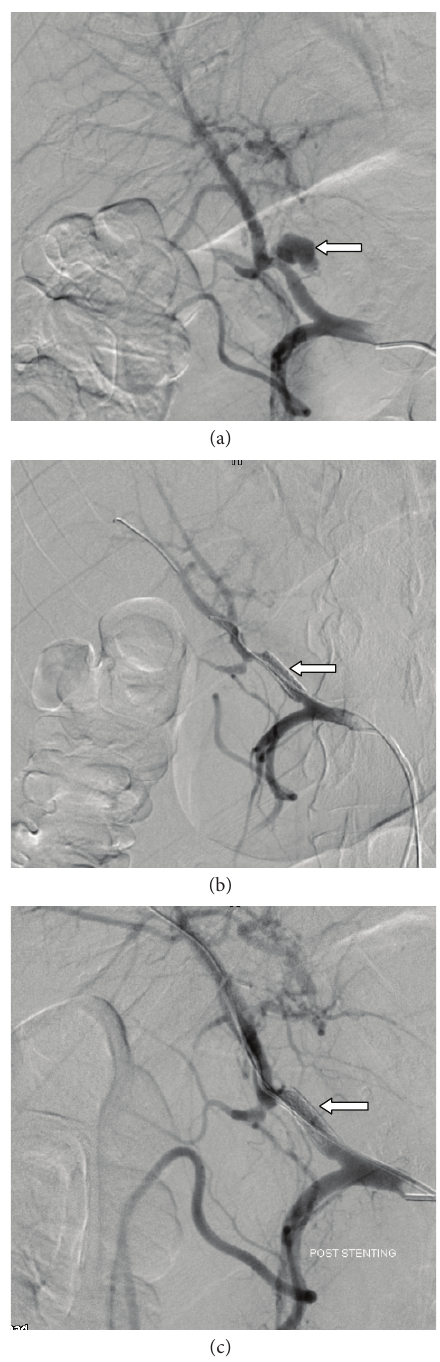
Figure 3: (a) Pseudoaneurysm arising from left hepatic artery (arrow in Figure 3(a)). (b) Covered stent placed across the site of pseudoaneurysm(arrowinFigure 3(b)).(c)Postcoveredstentplace- ment angiogram shows complete exclusion of pseudoaneurysm (arrow in Figure